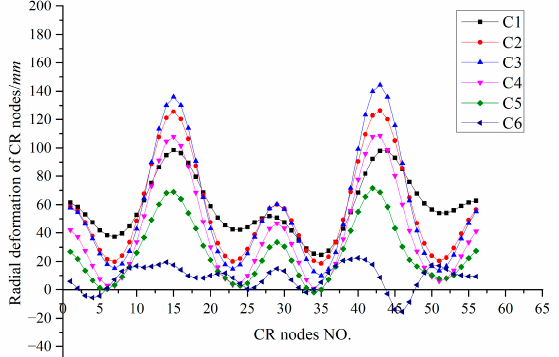
Figure 36. Radial deformation Ux of CR under various calculation conditions in local coordinate system.